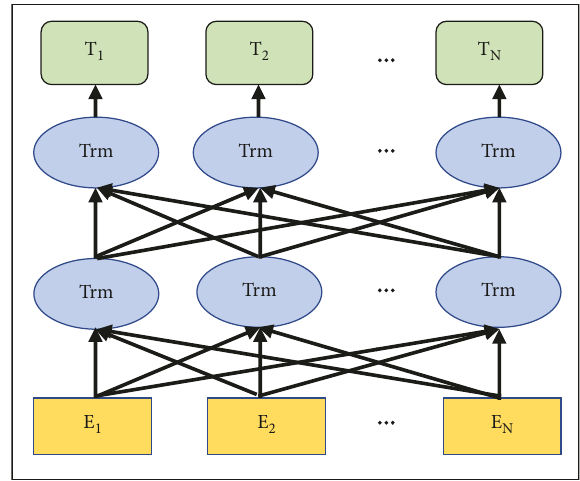
Figure 1: BERT model structure